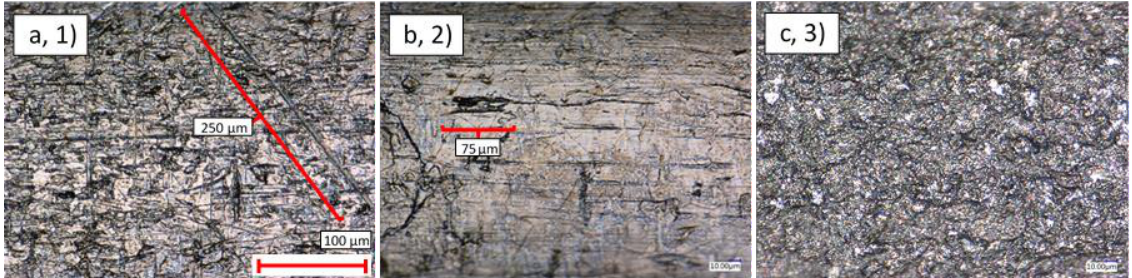
Figure 3. Optical microscopy ×1000 magnification view of the external surface of: ( a ) Cu Ni thin-walled pipe (1); ( b ) SS thick-walled pipe (2); ( c ) Ti Ni thin-walled pipe (3).